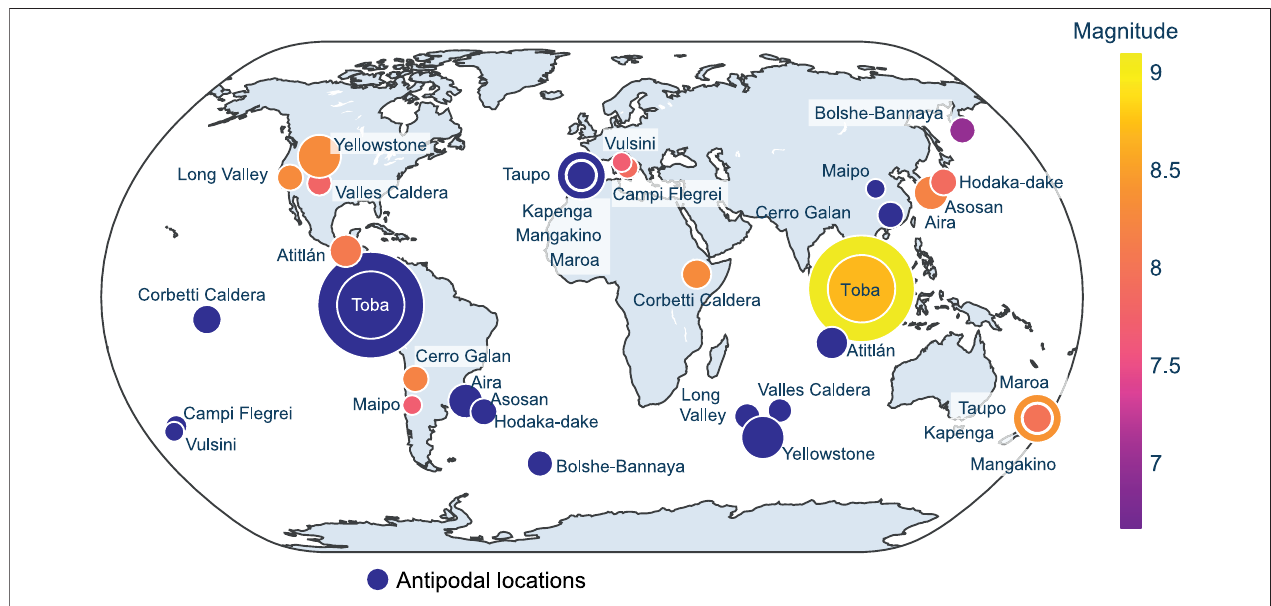
FIGURE 3 | Large volcanic eruptions ( > 400 km 3 bulk tephra volume) from the LaMEVE database over the last 2.1 Myr showing vanishingly small chance of supereruptionsoccurringatantipodallocations.Eruptionmagnitudes(bulktephravolume)arerepresentedbythesizeandcolorofthesymbol.Theantipodallocationfor each eruption is shown as blue circles. It is noteworthy that the main potentially antipodal relationship between two supervolcano eruptions also close in time is the YTT and LCY eruption pair (~2,200 km between the Atitlán caldera and the antipodal location of the Toba caldera). Note that Toba has sourced two Quaternary supereruptions, with YTT represented by the larger circle (id.